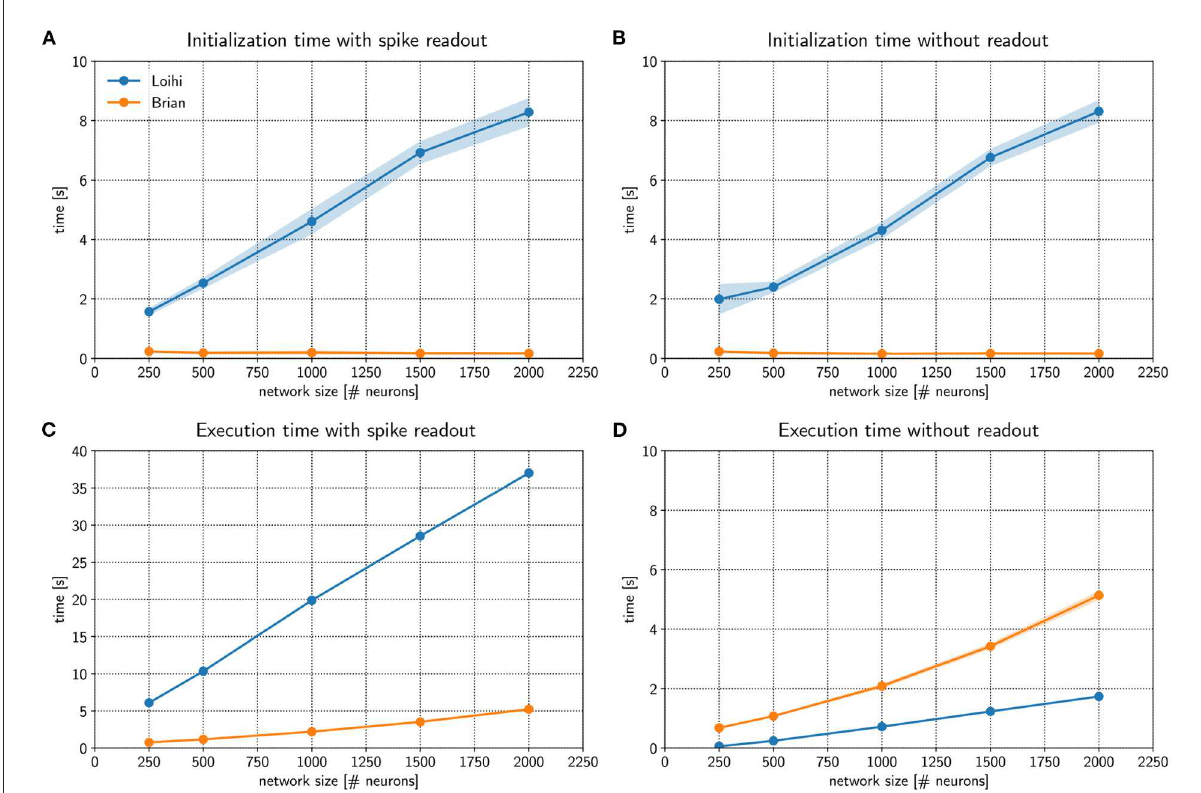
FIGURE3 Comparing performance of the Loihi emulator with the Loihi chip. The initialization time (A,B) and execution time (C,D) for Loihi -based (blue) and emulator-based (orange) simulations was compared for different network sizes. In one case spikes were read out for all neurons and time steps (A,C) and in a second case no spikes were read out (B,D) . The Brian -based simulation using Brian2Loihi had faster initialization times across all network sizes, both with and without spike monitoring. For the execution time, a Brian -based simulation was only faster when a read out was defined. If no spikes were read out, Loihi -based execution is faster. Execution time both on the Loihi chip and using the emulator increase with network size. Points show the mean and shaded areas show the standard deviation over 5